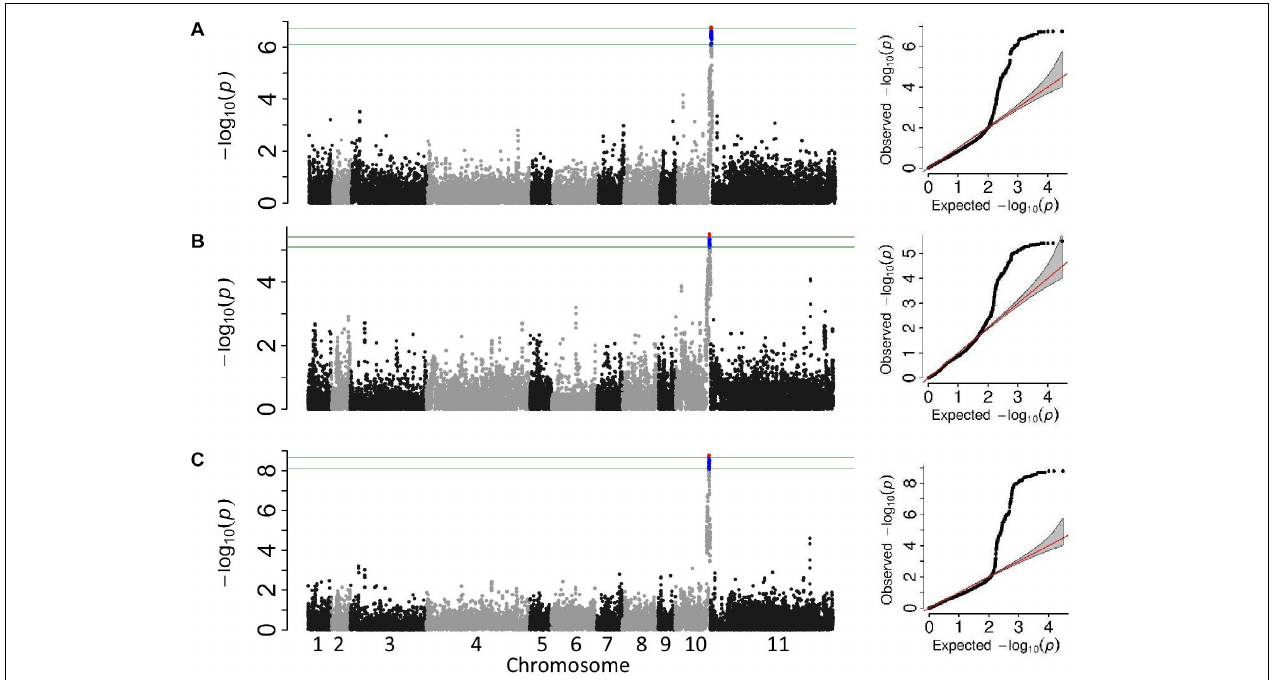
FIGURE 3 | Manhattan and QQ plots from the genome-wide association studies analyses of the Andean breeding population. The upper horizontal bar represents the cutoff for the most 0.01% significant single-nucleotide polymorphisms (SNP) (depicted in red). The lower horizontal bar represents the cutoff for the 0.1% significant SNP (depicted in blue). Both cutoffs are based on 1,000 bootstraps of the empirical distribution of the p -values. (A) Univariate mixed model of the unifoliate phenotype, (B) univariate mixed model of the trifoliate phenotype, and (C) multi-variate mixed model of unifoliate and trifoliate